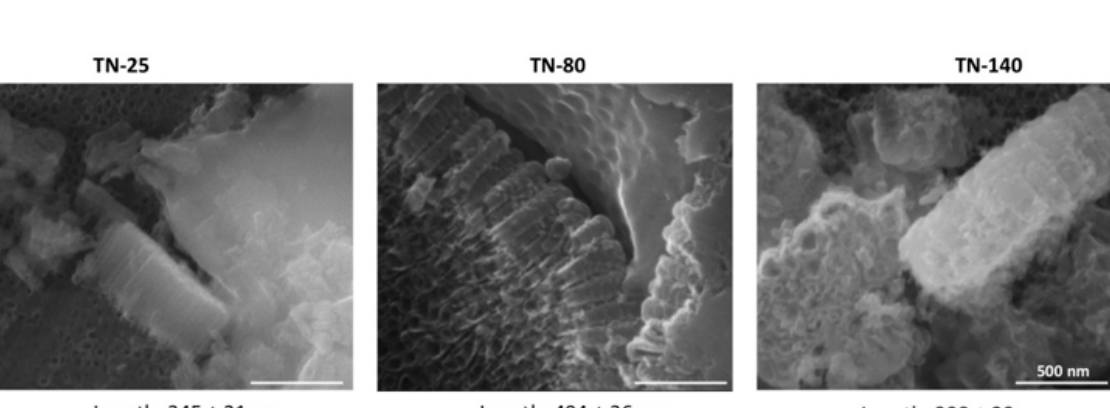
Figure 1. SEM micrographs of ( A ) T-untreated, ( B ) TNs-25, ( C ) TNs-80, and ( D ) TNs-140 surfaces. AFM micrographs of ( E ) T-untreated, ( F ) TNs-25, ( G ) TNs-80, and ( H ) TNs-140 surfaces. ( I ) SEM images of TN-25, TN-80, and TN-140 surfaces after scratching them to mechanically delaminate the nanotubular oxide layer. The lengths are 345 ± 21 nm, 404 ± 36 nm, and 398 ± 29 nm for TN-25, TN-80, and TN-140, respectively. Scale bars are 500 nm. Table 3. Water contact angles, nanophase and micron-phase surface roughness values, and surface areas of T-untreated, TNs-25, TNs-80, and TNs-140 samples.